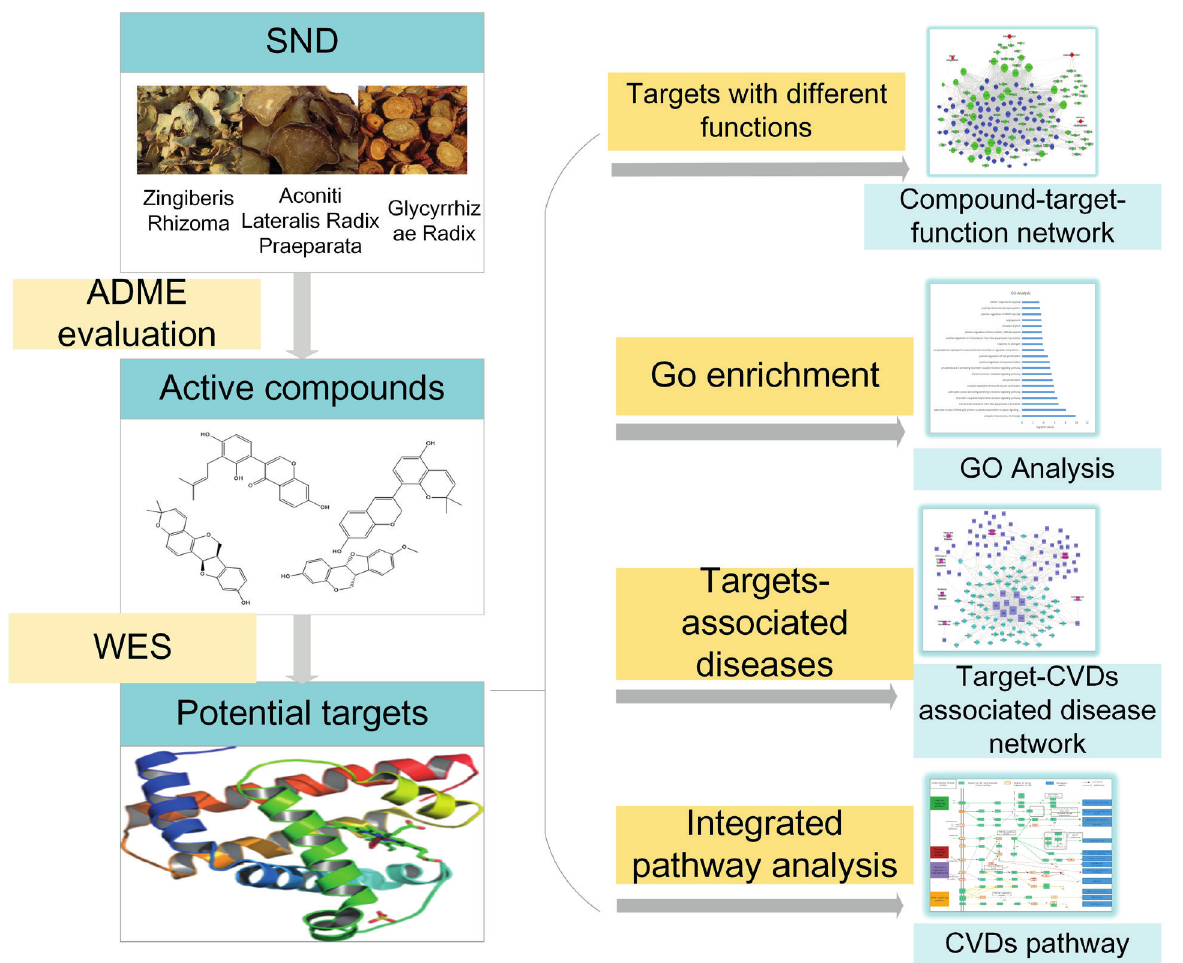
Figure 1 - Worflow for SND in treating